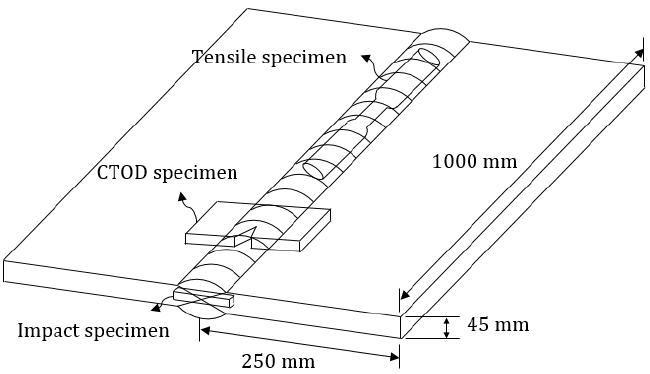
Figure 4. Schematic diagram of the welded panel and test specimen.